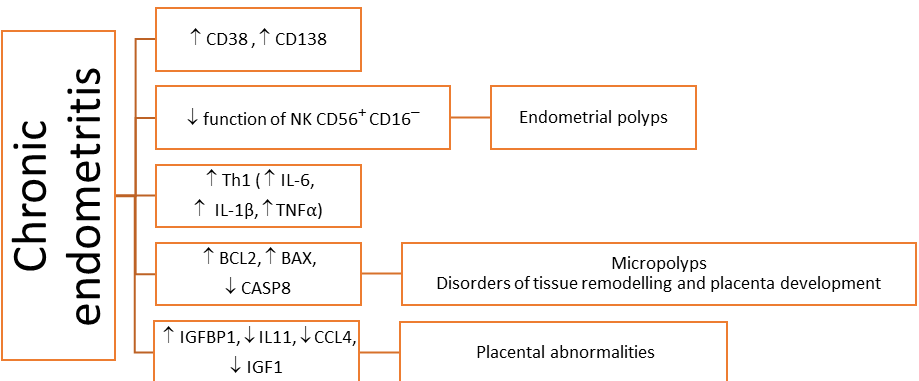
Figure 4. Pathomechanisms impeding the course of implantation in women with chronic endometritis (CE). Legend: ↑ : increase; ↓ : decrease; BAX: proapoptotic BAX protein; BCL2: anti-apoptotic